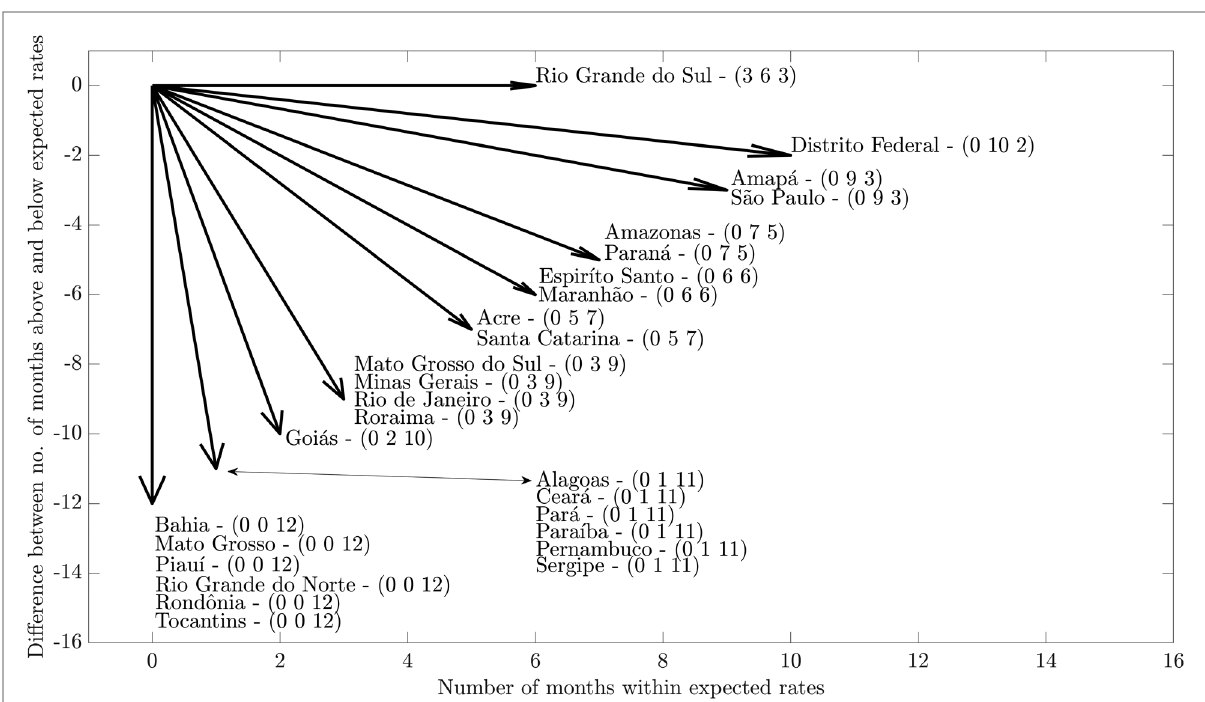
FIGURE 3 Resultant vectors obtained from the control diagrams of monthly rates of visits performed in primary health care services in Brazil, per thousand children up to fi ve years of age, during the pandemic (from April 2020 to March 2021) compared to pre-pandemic period (from April 2017 to March 2020), according to states and the Federal District. Numbers in parenthesis represents number of months above, within and below expected rates,